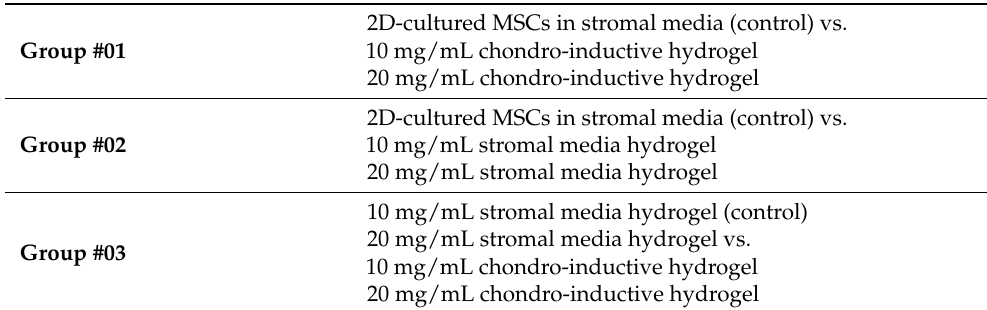
Table 2. Experimental groups for gene expression analysis of DUC hydrogel (10 mg/mL or 20